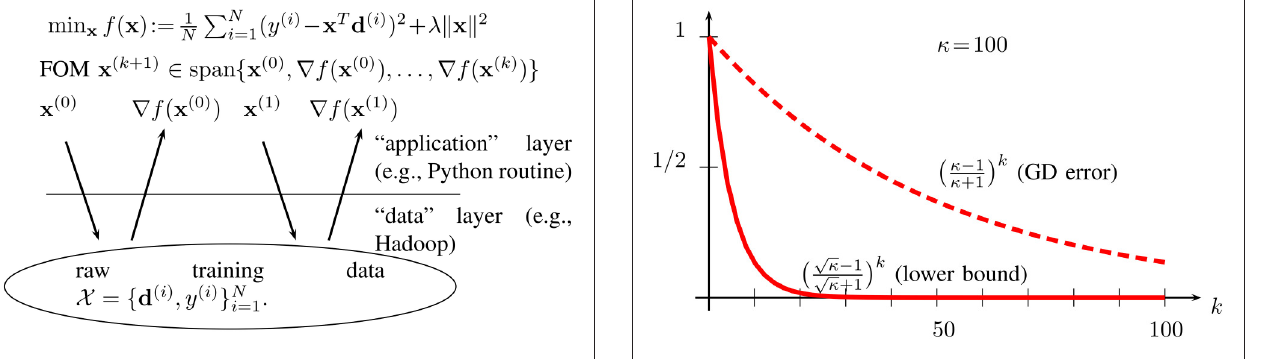
(30) on convergence rate for any FOM minimizing functions f ( U / L condition number κ = =